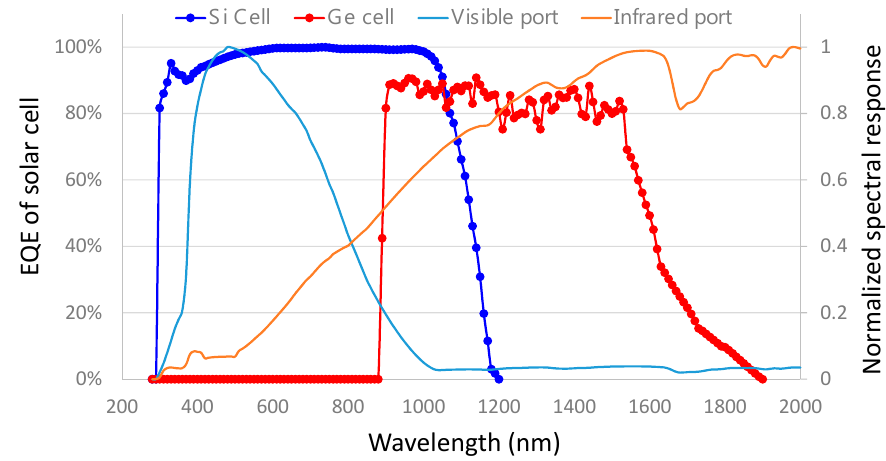
Figure 8. External quantum efficiency (EQE) data for the aforementioned silicon and germanium cells [32,33] and the normalized spectral responses of the visible and infrared ports in the proposed module.